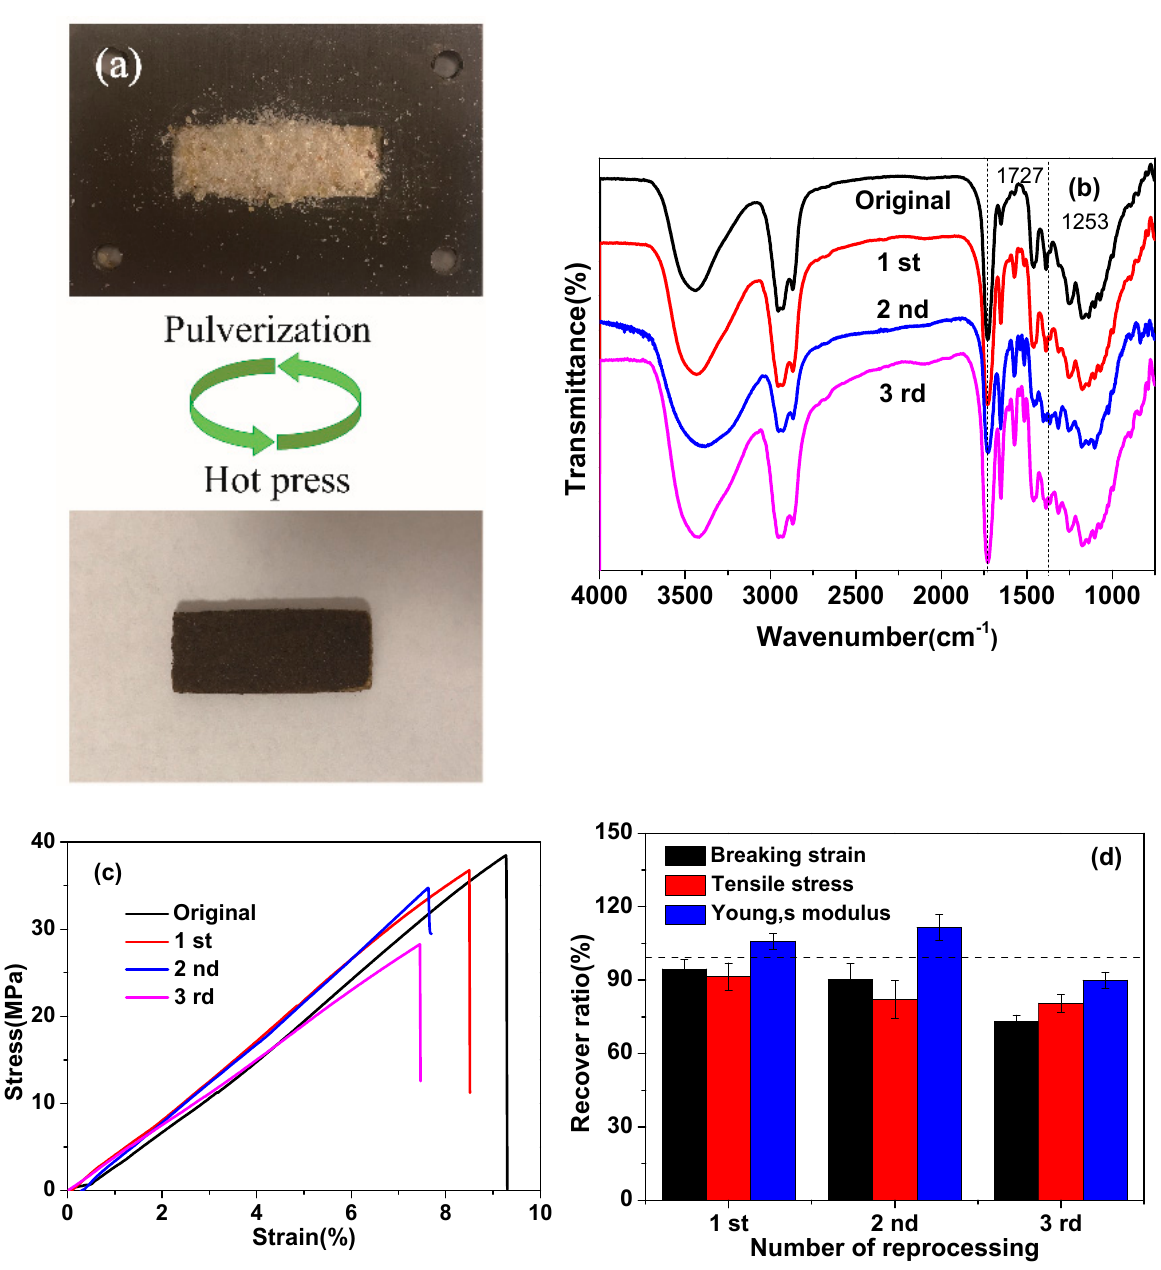
Figure 11. ( a ) Optical microscope images of thermal recycling performance of 20% C-FPAE by hot press. ( b ) FTIR spectra of 20% C-FPAE with different generations of reprocessing. ( c ) Tensile curves of samples with different generations of reprocessing. ( d ) Recovery ratios of samples with different generations of reprocessing.